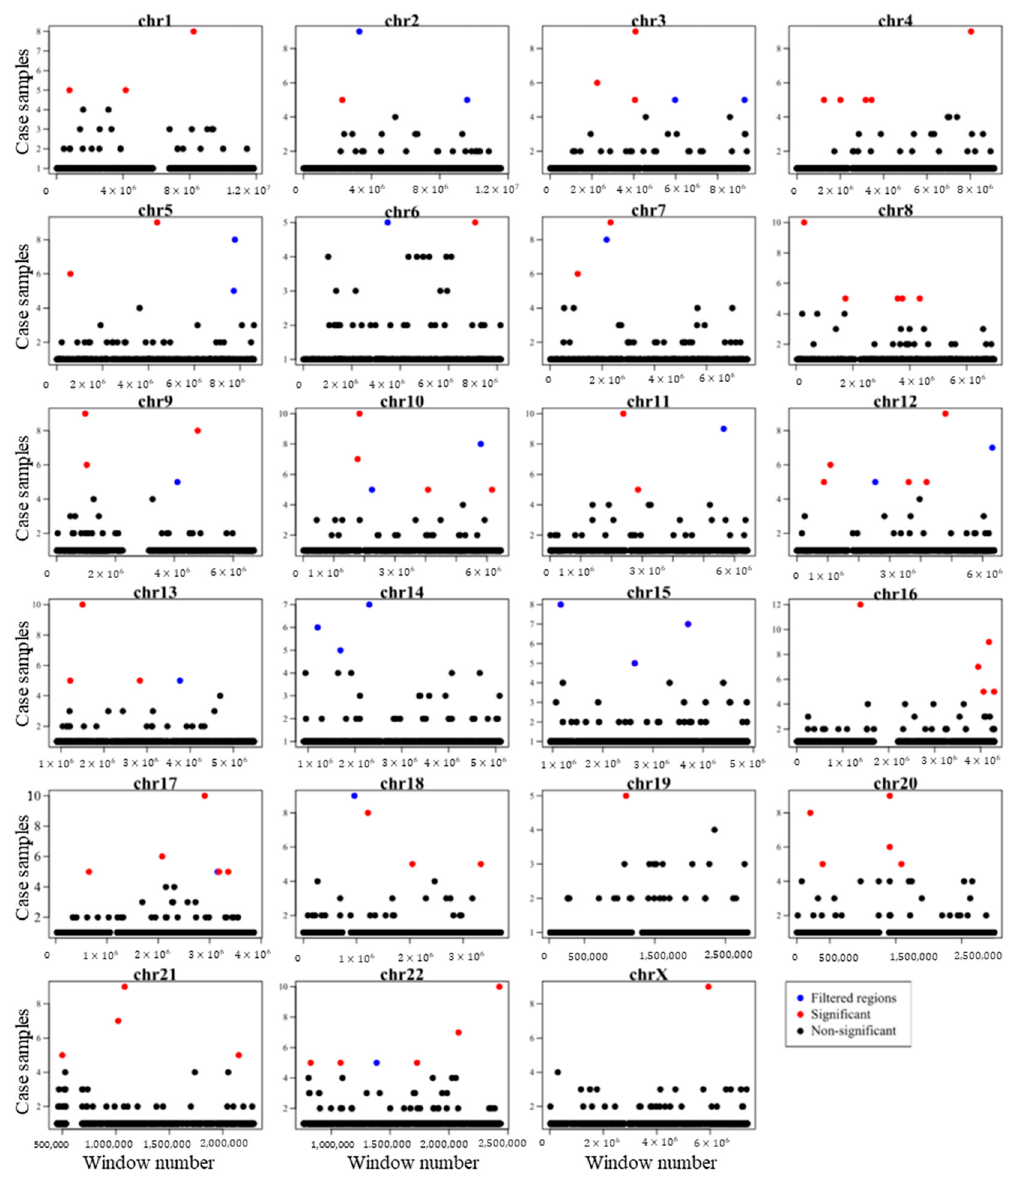
Figure 4. A genome-wide overview of somatic mutation hotspots (red dots) and filtered regions (containing masked regions and repetitive regions (blue dots) and non-significant regions (black dots)) was identified in this study. The figure illustrates the distribution of 21 bp bin-size windows encompassing PC-related somatic point mutations across the genome. The x -axis shows the window number and y -axis shows the number of case samples covered by the window. For each window, our proposed method calculates the p -value of mutation recurrence using the Poisson binomial distribution. Problematic regions, including masked regions and repetitive regions, were then excluded and bins with a p -value < 0.001 were selected.